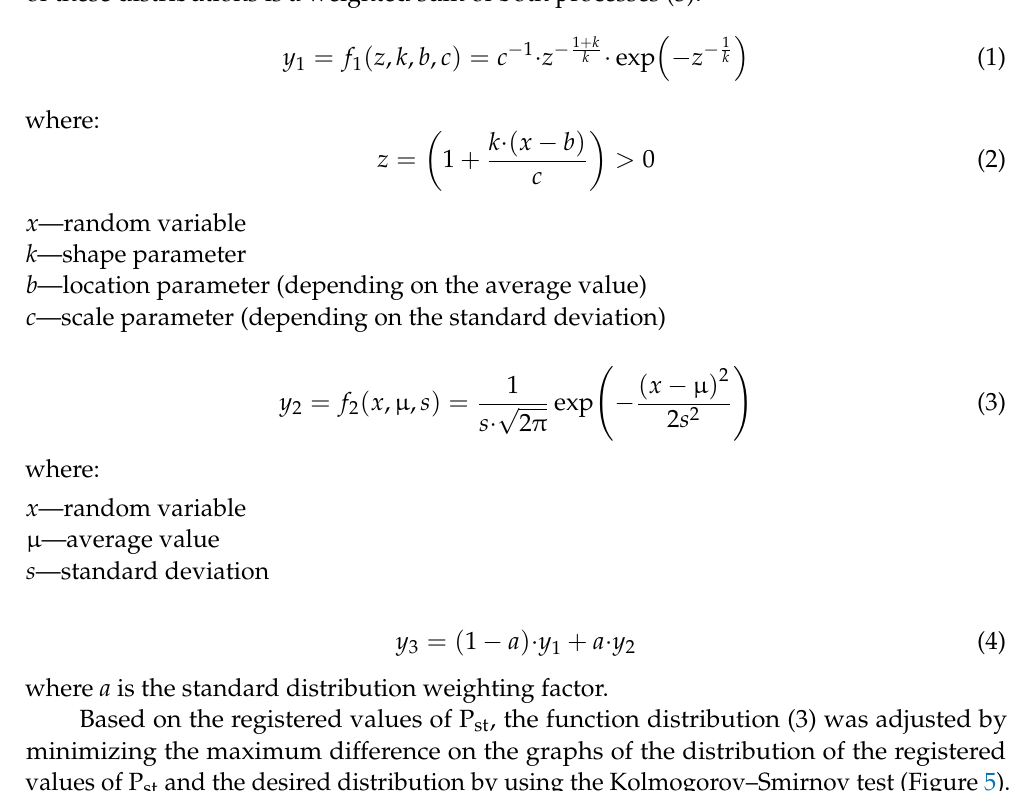
Figure 4. Histogram of P st along with a distribution table for an operational furnace. The histogram in Figure 4 is a combination of two statistical distributions: the general- ized distribution of the extreme value (1) and the normal distribution (2). The composition of these distributions is a weighted sum of both processes